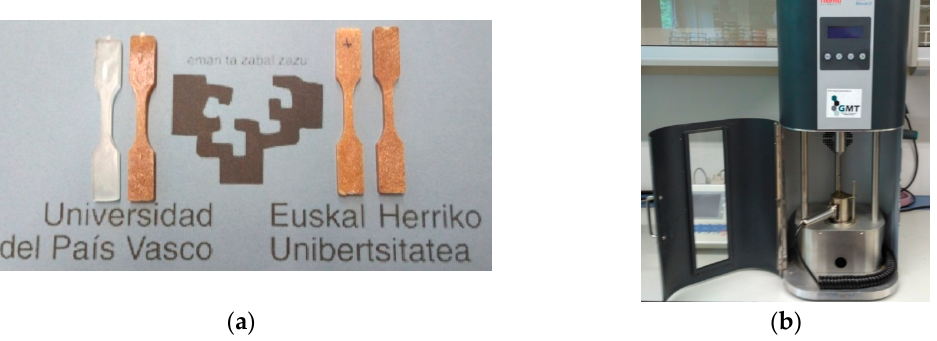
Figure 1. ( a ) Image of tensile specimens obtained after injection process; and ( b ) set-up machine used.